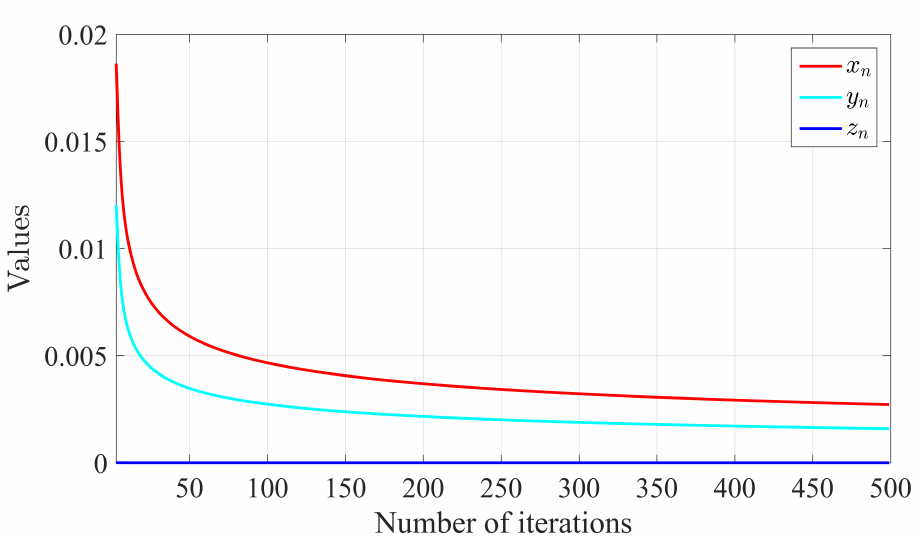
Figure 2. Plotting of { x n } , { y n } and { z n } converging to 0 as n → ∞ .